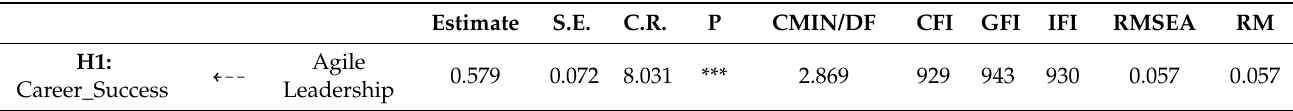
Table 3. Direct effect of agile leadership on career success.